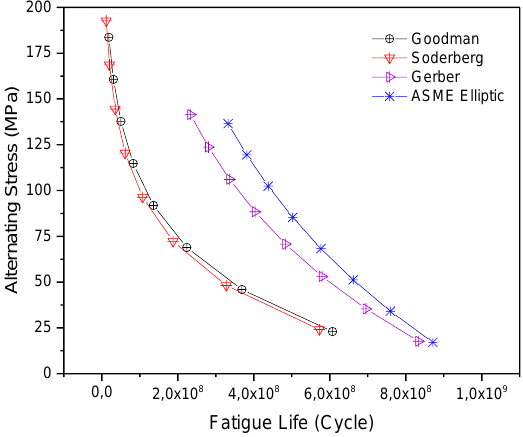
Figure 26. Relationship Between Alternating Stress and Fatigue Life using Different Mean Stress Correction Figure 26: Relationship between alternating stress and fatigue life using different mean stress correction Theories